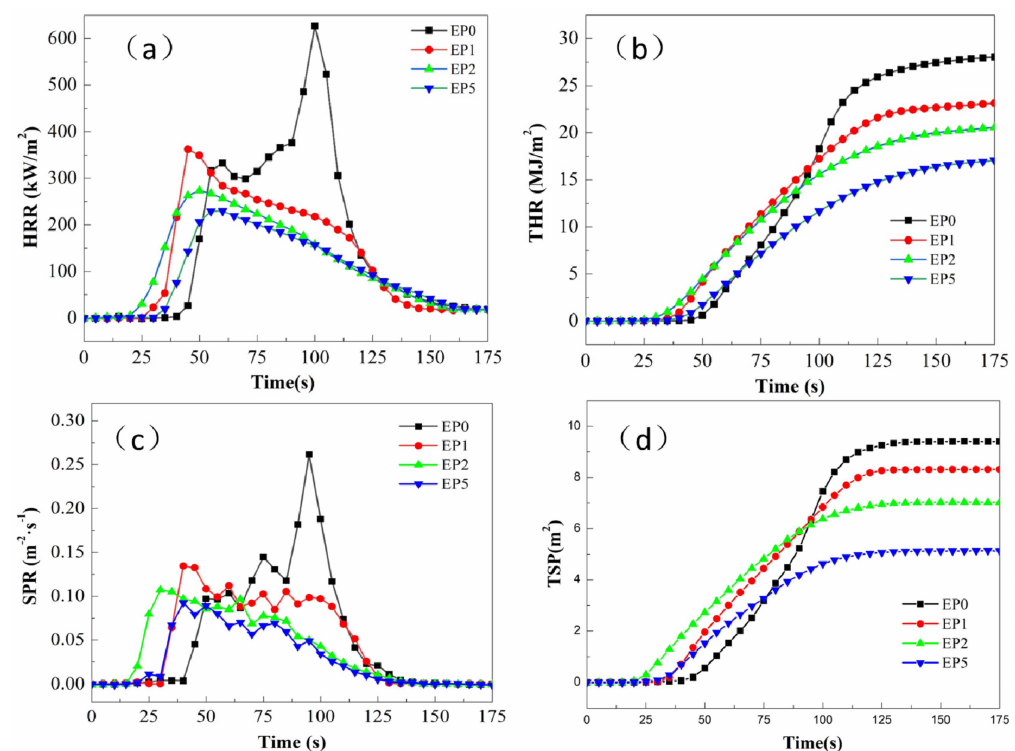
Figure 5. ( a ) HRR curves of flame-retardant coatings; ( b ) THR curves of flame-retardant coatings; ( c ) SPR curves of flame-retardant coatings; ( d ) TSP curves of flame-retardant